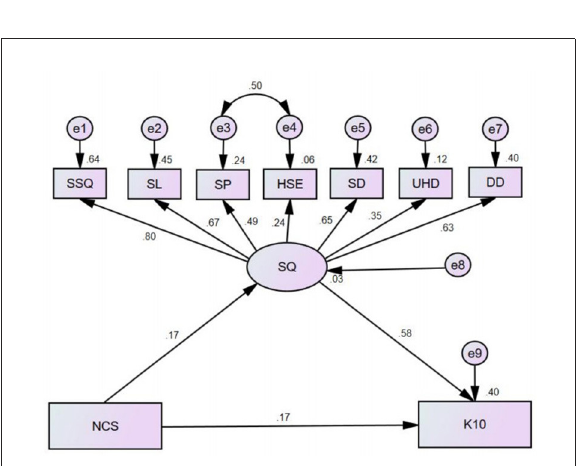
FIGURE3 Standardized estimates of the relationship between negative coping style, sleep quality, and psychological distress ( n = 812, Shandong, China).